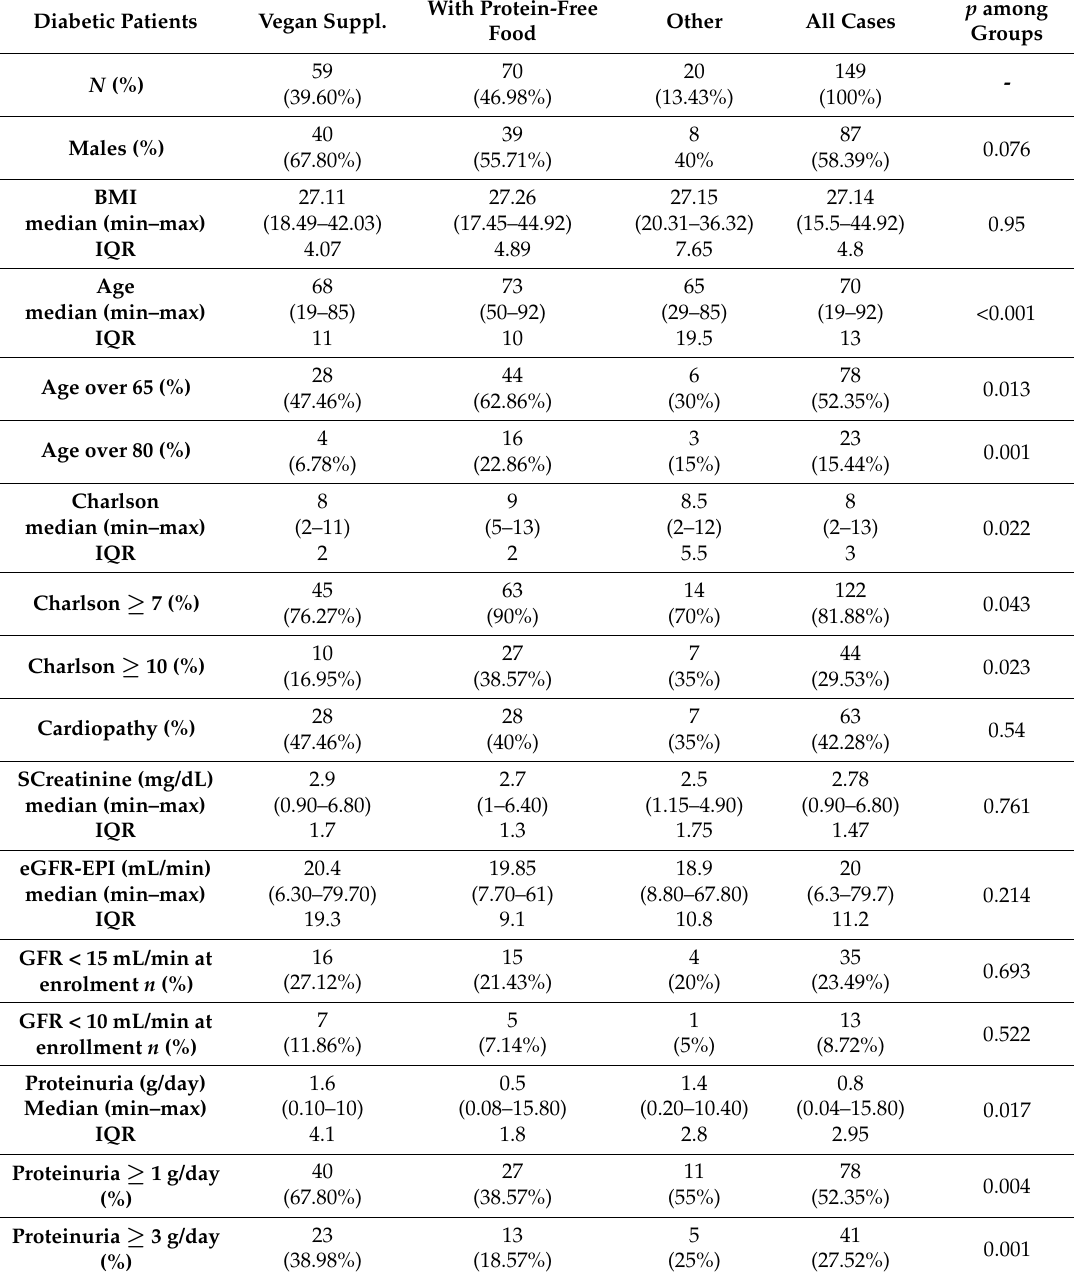
Table 3. Baseline characteristics of the diabetic CKD population, according to the diets chosen. Diabetic